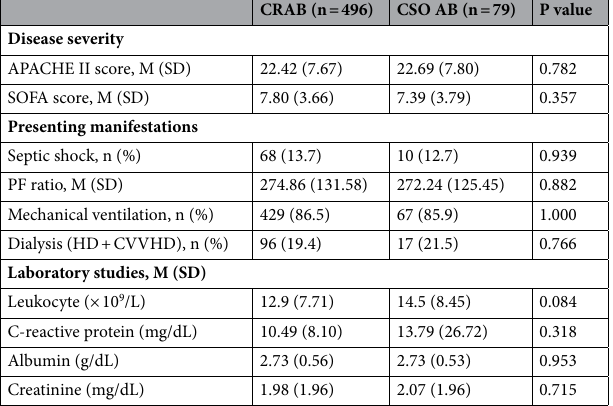
Table 2. Initial presentation of disease severity in patients with CRAB and COS AB pneumonia. APACHE II score was recorded at ICU admission; other variables were recorded on the pneumonia index date. M (SD) mean (standard deviation), HD hemodialysis, CVVHD continuous venovenous hemodialysis.